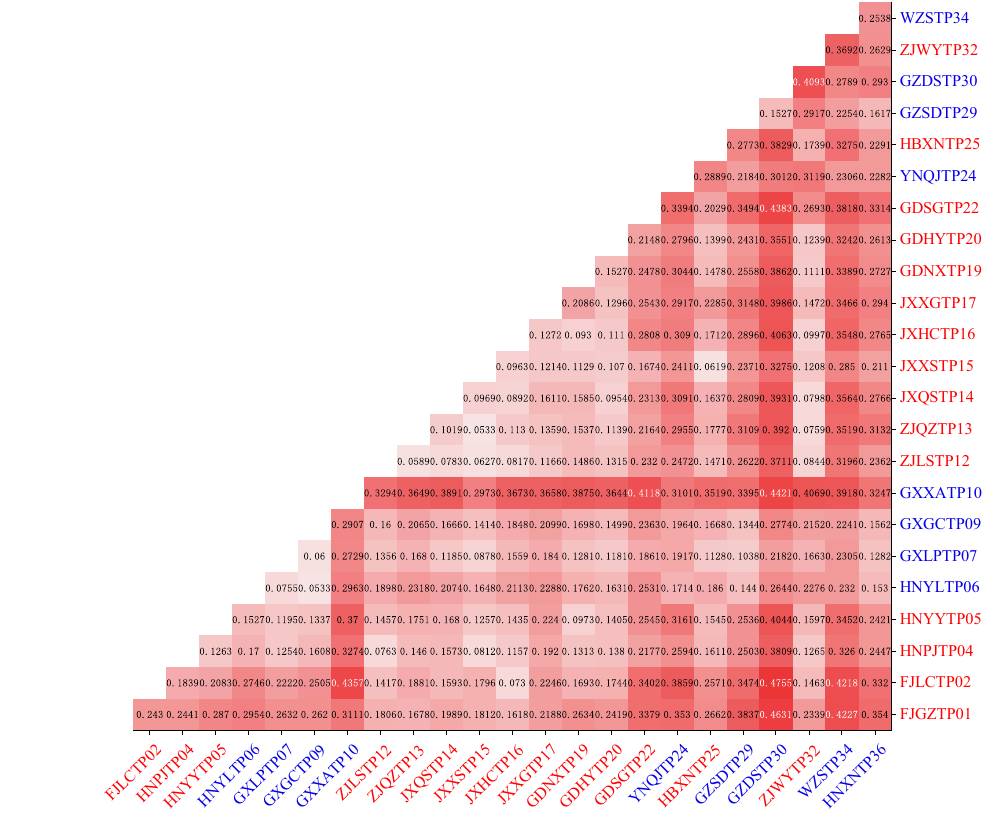
Figure 6. Genetic distance ( F ST ) for D. catenatum . The samples from Group I were in red font, and the samples from Group II were in blue font.